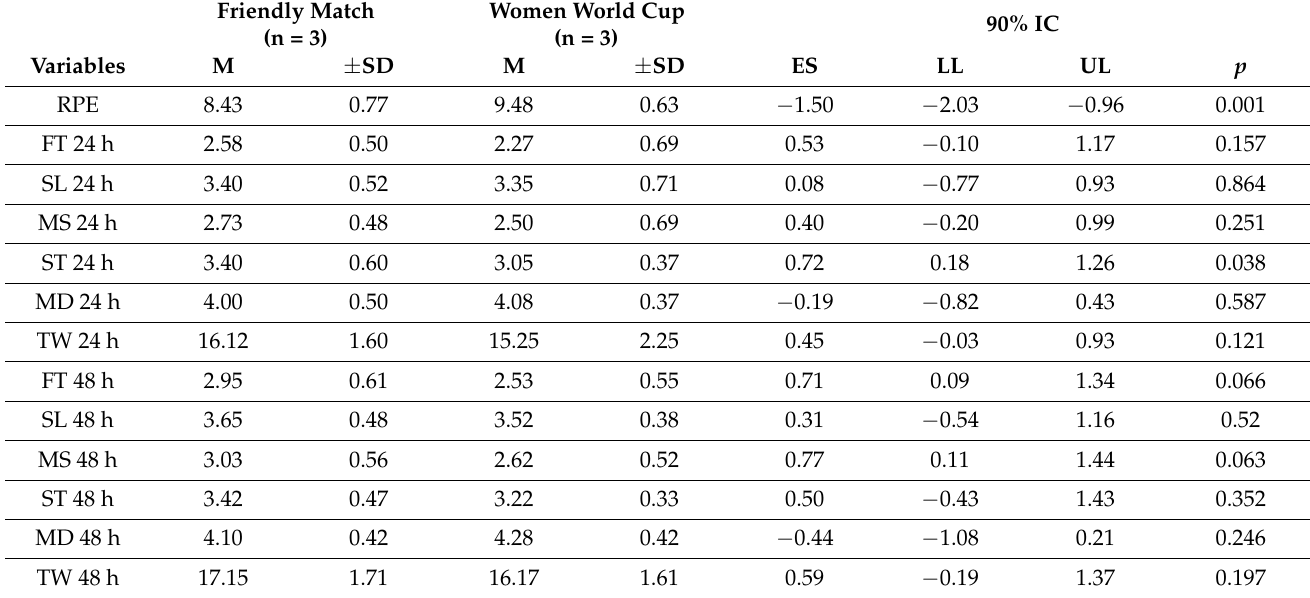
6 of 11 Figure 4. Standardized difference of external load between periods. FM friendly match; WWC Women world cup; MM match minutes; TD total distance; HSR high speed running; NS number of sprint; MV